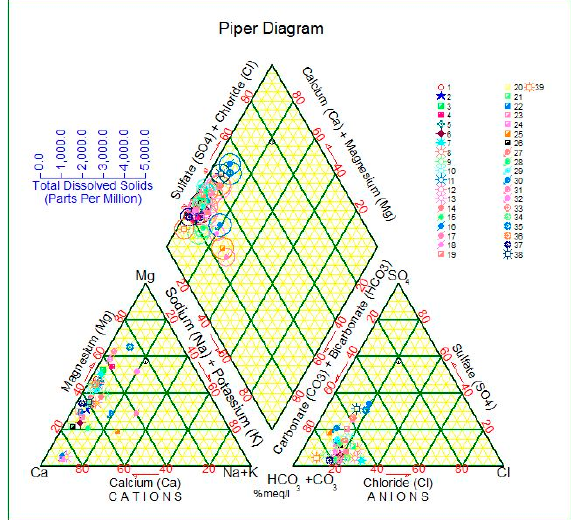
Figure 6. Hydrochemical composition of the groundwater analysis based on a Piper diagram (in % meq/L) from the HSB in the dry season.